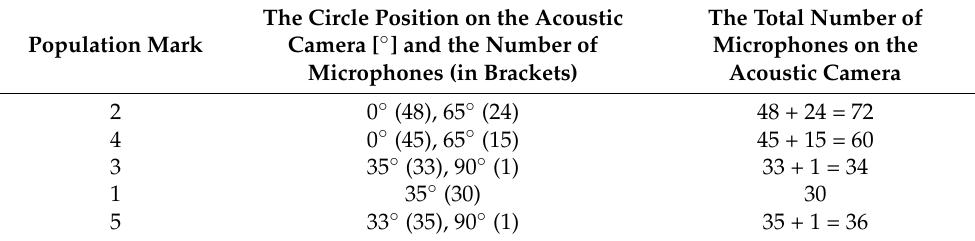
The Total Number of Microphones on